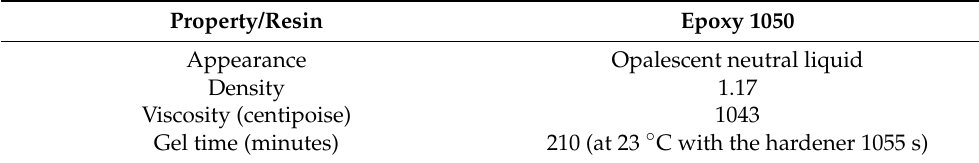
Table 2. Typical properties of liquid considered resins.